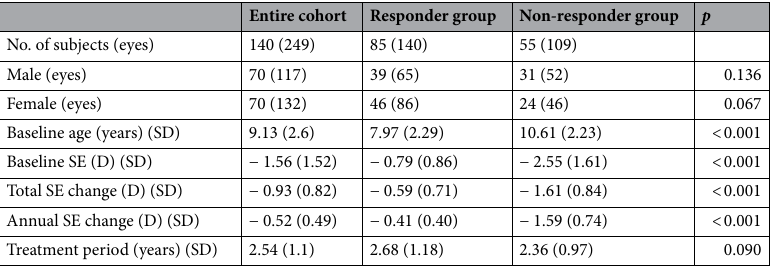
Table 1. Demographic characteristics of children in the study. The p values compare the responder and non- responder groups. D diopter, SE spherical equivalent, SD standard deviation.